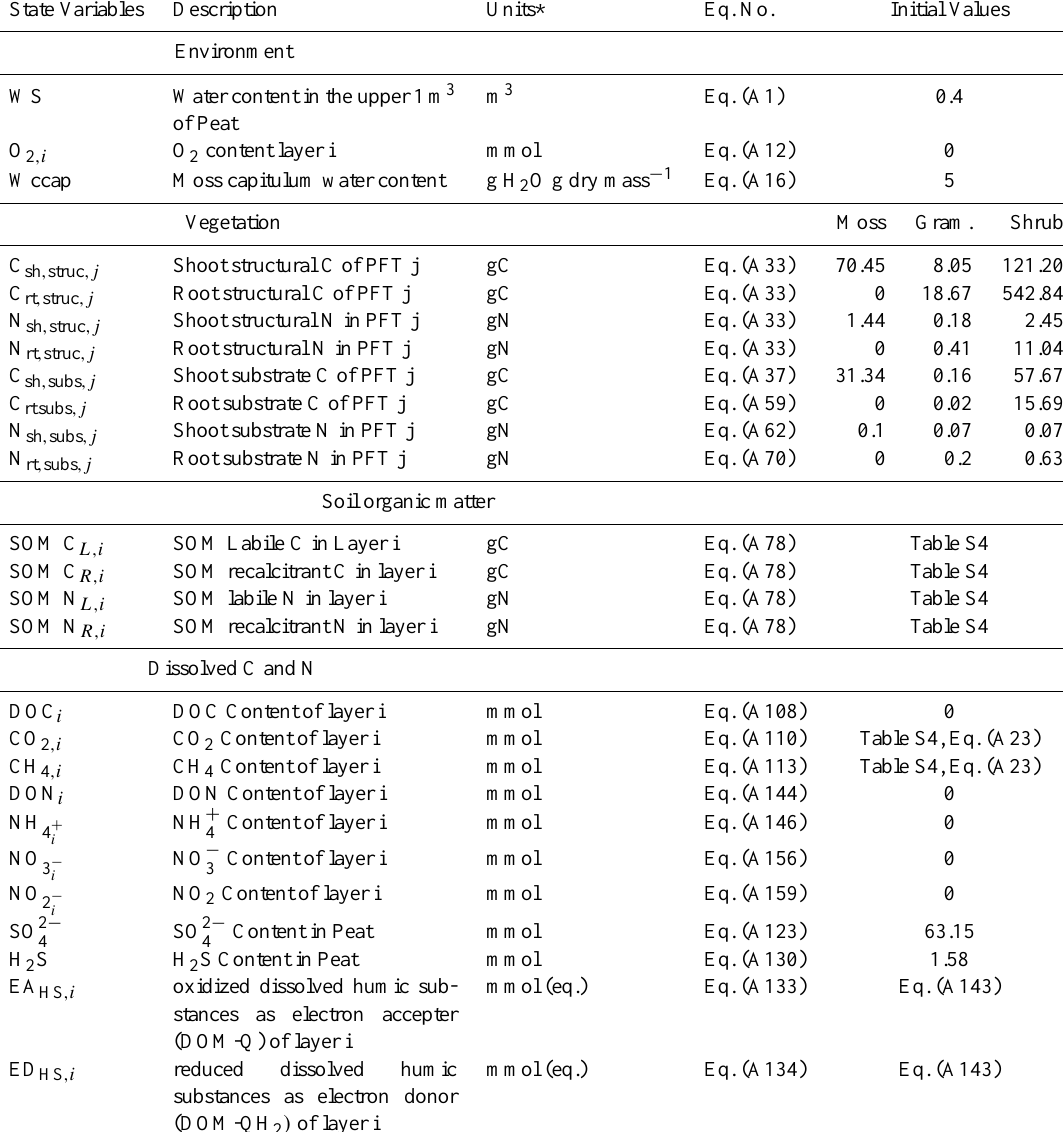
Table 1. State variables in the